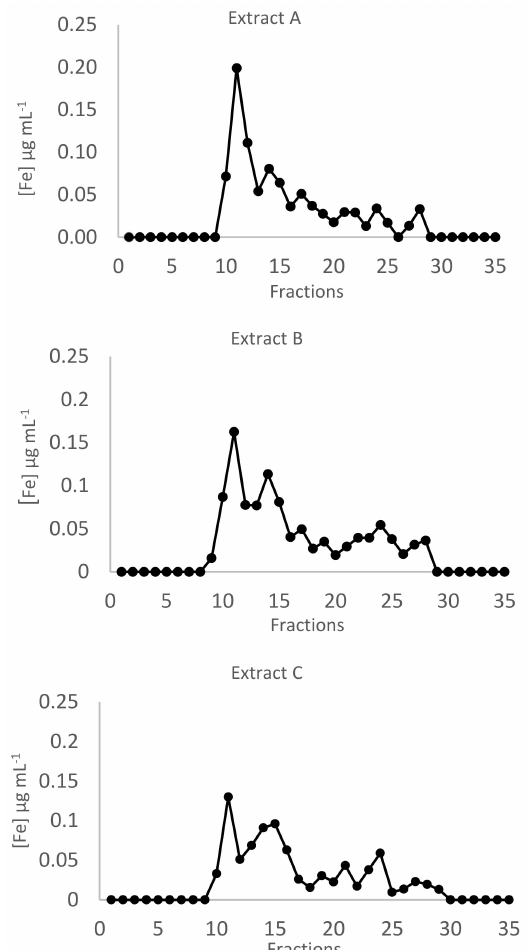
Figure 4. Iron chromatographic profiles after size exclusion chromatography of extracts A – C obtained from samples grown at 1, 5, and 10 mg Fe L − 1 , respectively. Each chromatogram is the mean of two independent chromatographies. Iron concentration is expressed as µ g mL − 1